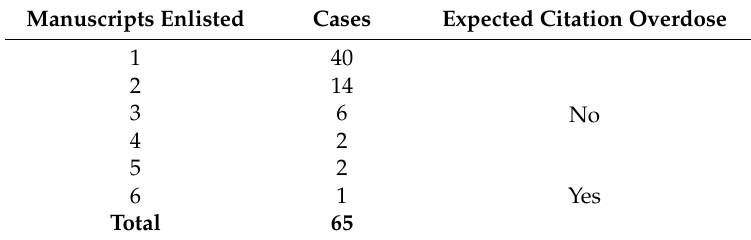
65 Information from the right hand side column is according to our own subjective